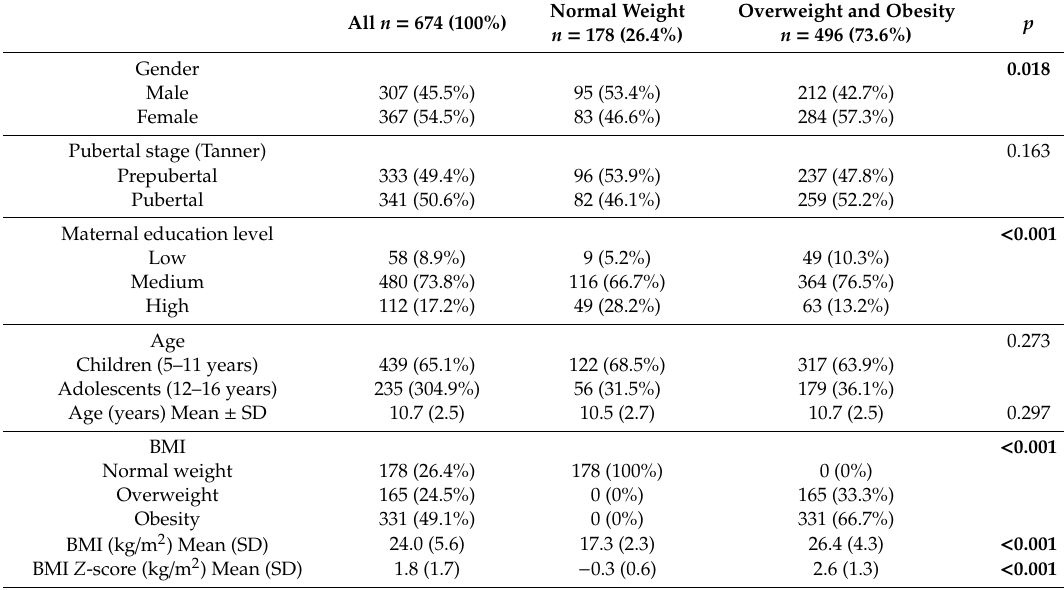
Table 1. Descriptive characteristics of children and adolescents by body mass index (BMI) status (GENOBOX